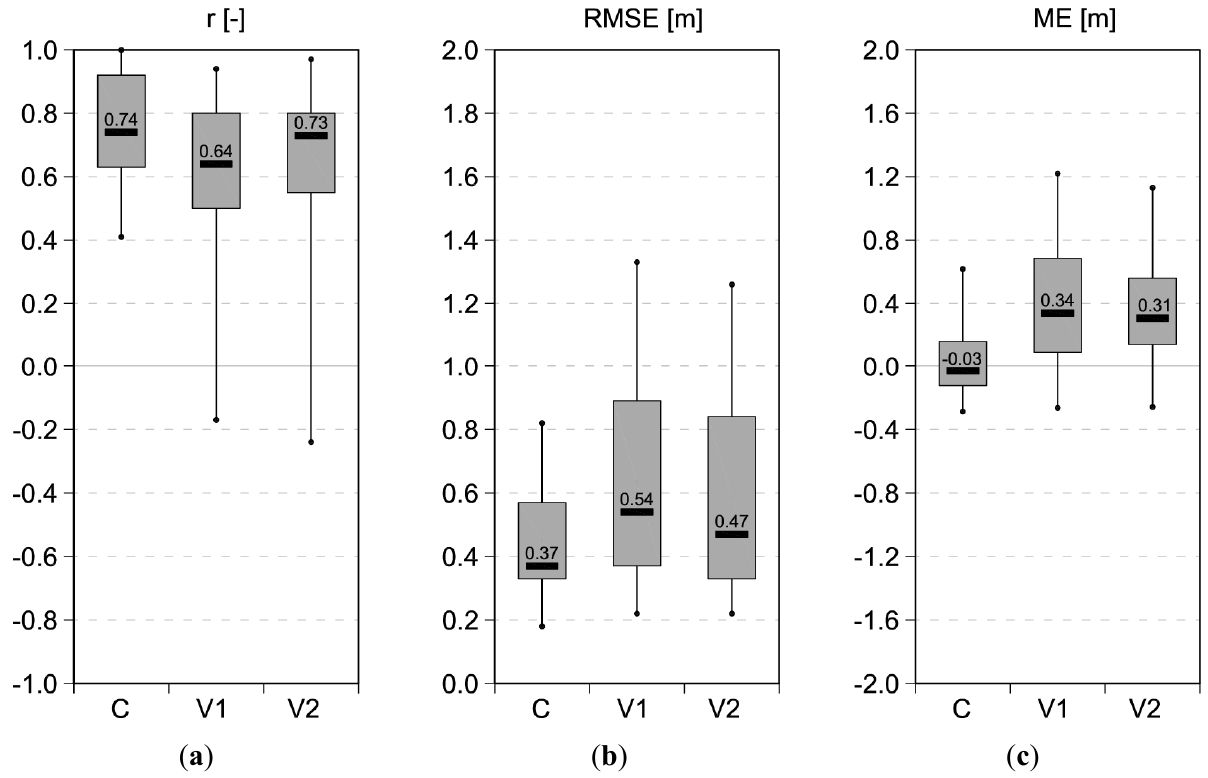
Figure 3. Comparison between the calibration (C), validation without land-use changes (V1), and validation with land-use changes (V2) for correlation ( a ); root mean square error ( b ) and mean error ( c